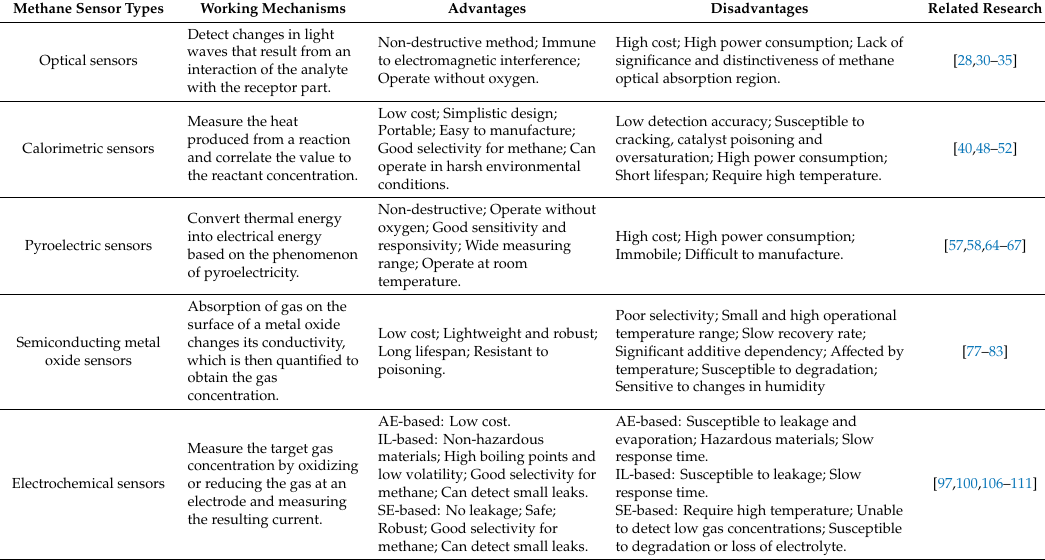
Table 1. Comparison of di ff erent methane